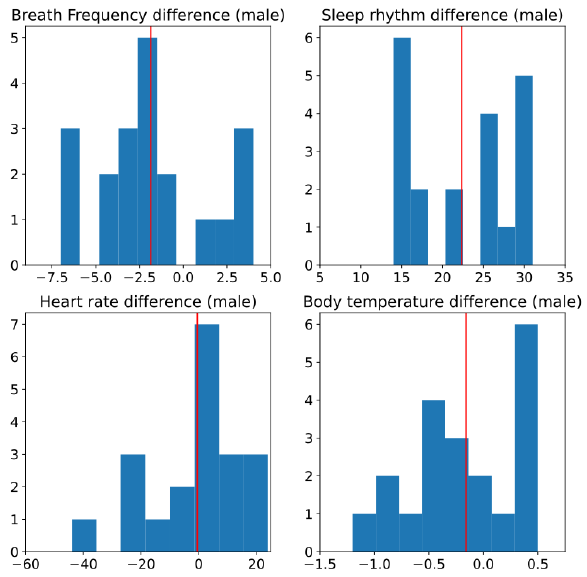
Figure 14. Histogram of difference between two conditions, without and with sensors, for male subjects. Red line is estimated